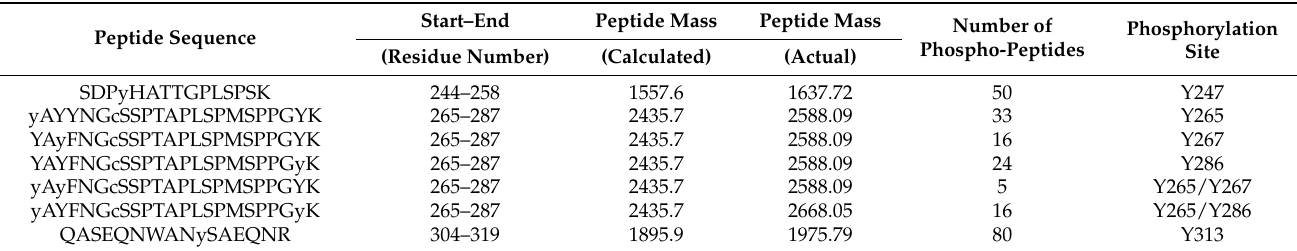
Table 2. Phospho-Tyr containing peptides identified from the mass spectroscopy of Cx43CT in vitro phosphorylated by ITK.